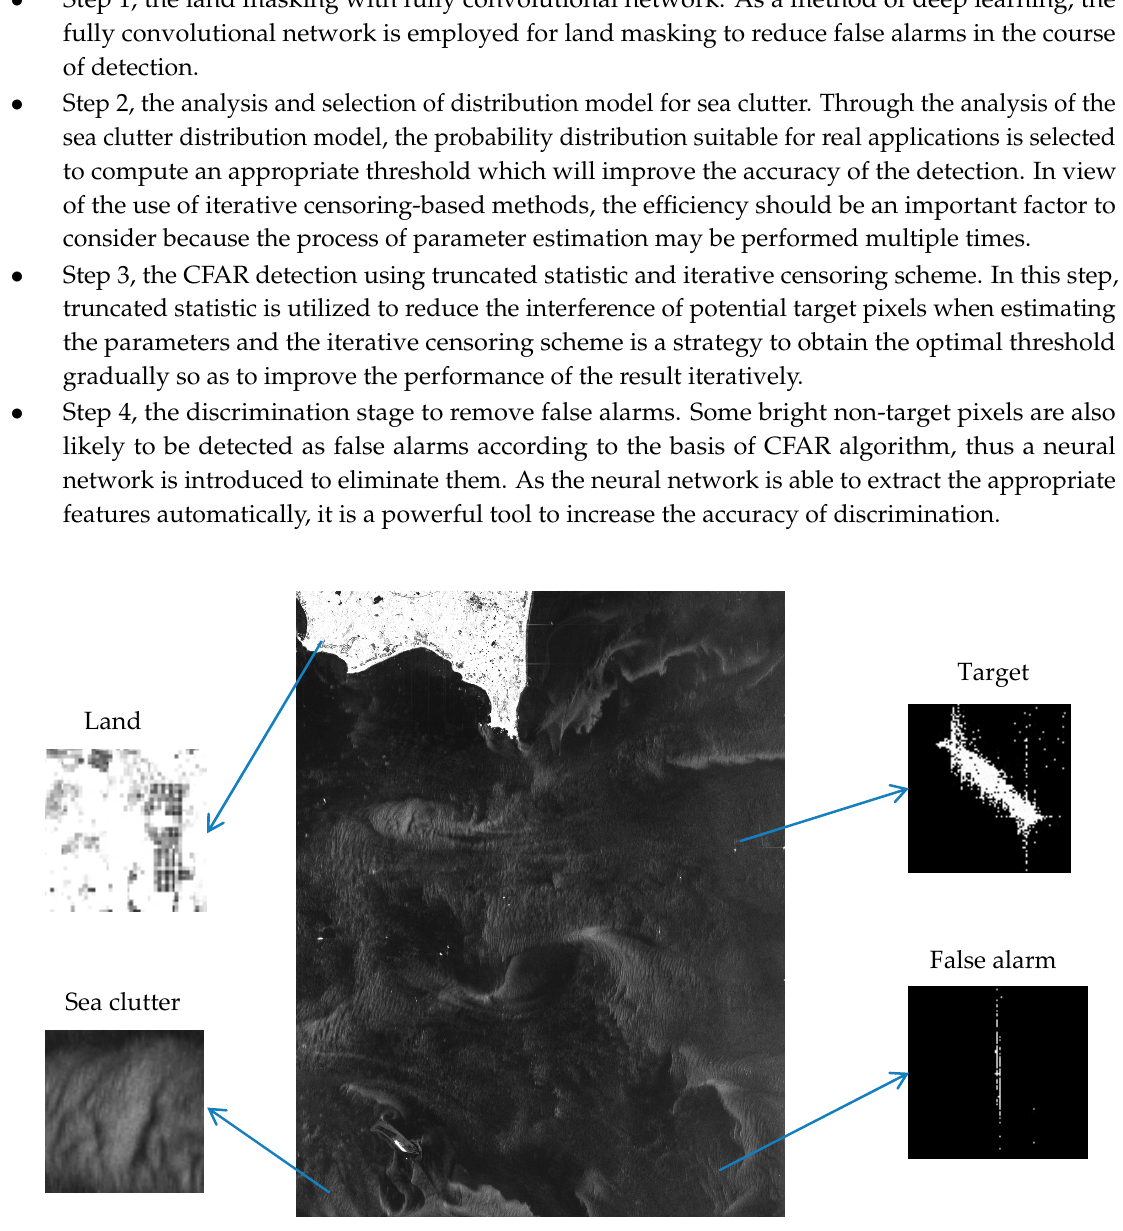
Figure 1. A GF-3 SAR image containing land, several ships and sea clutter.